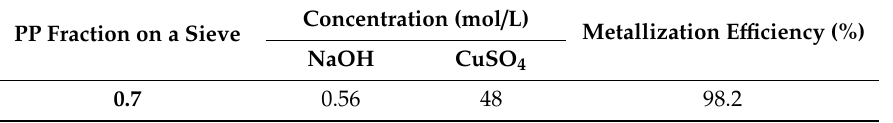
Figure 12. Kinetic curves of reduction of copper ions on the activated surface of polypropylene for the fraction of 0.7 depending on the degree of its loading. Concentration (mmol/L): CuSO 4 –48; NaOH– Table 4. Metallization e ffi ciency of washed activated 560; EDTA-Na 2 –67; formaldehyde–366.